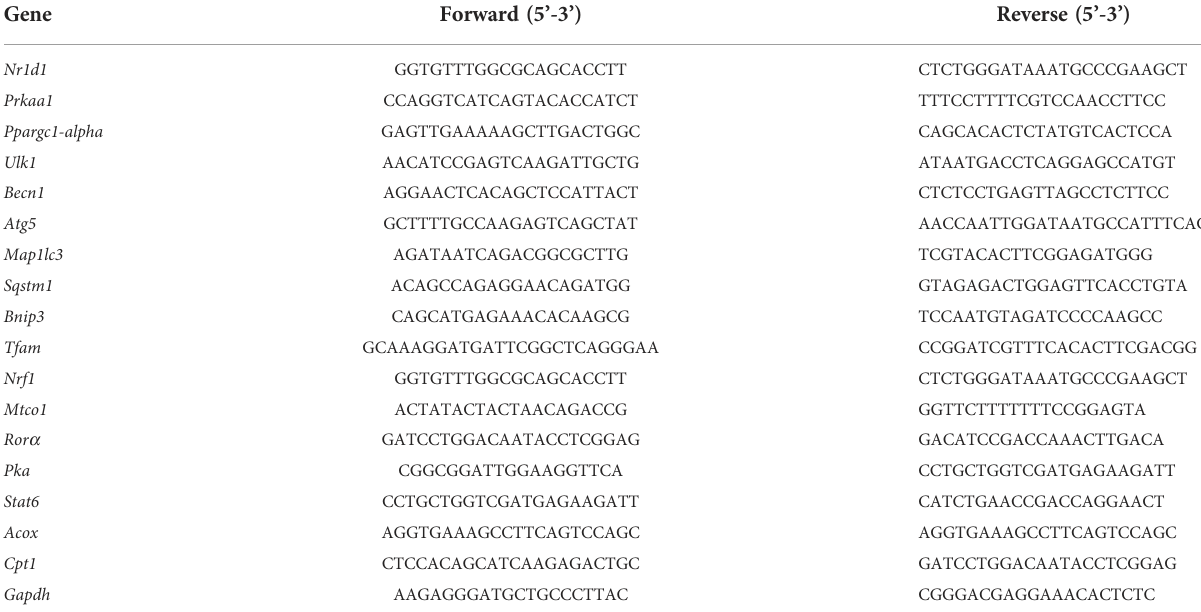
TABLE 1 Primers sequences used in this